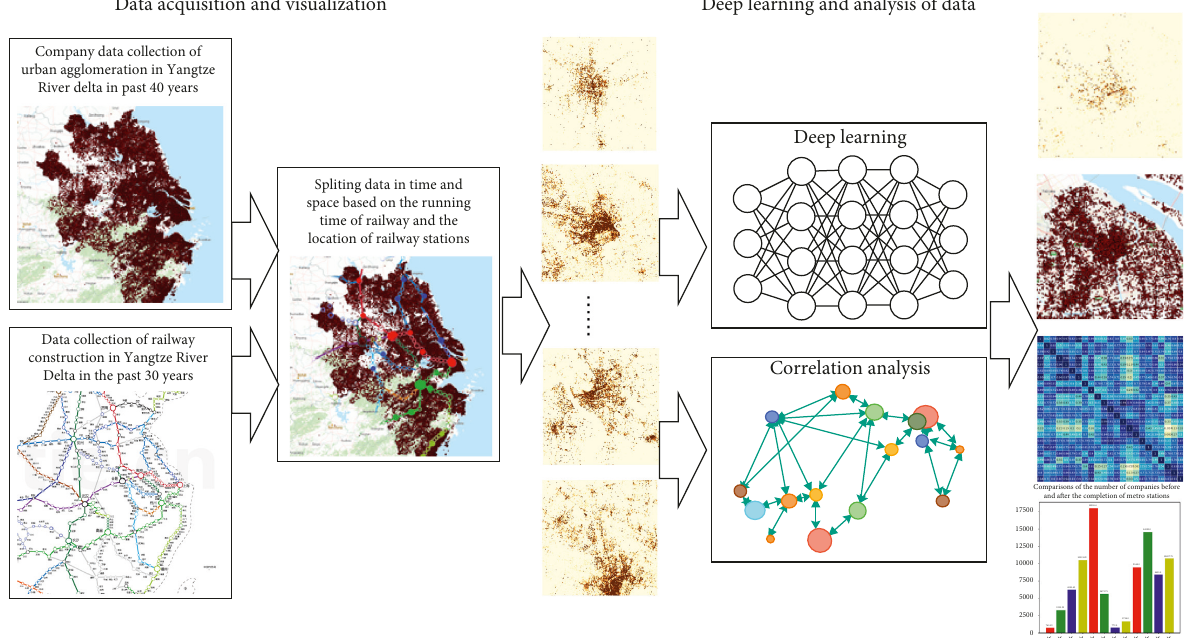
Figure 1: Flow chart for collection, processing, deep learning, and analysis of enterprise data in the Yangtze River